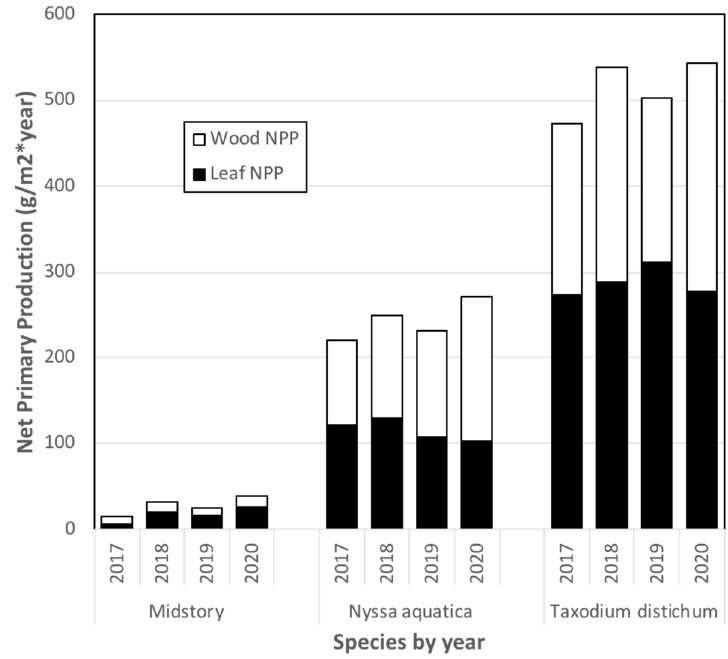
Figure 12. Total aboveground production (gm m − 2 y − 1 ) across years for each species type.